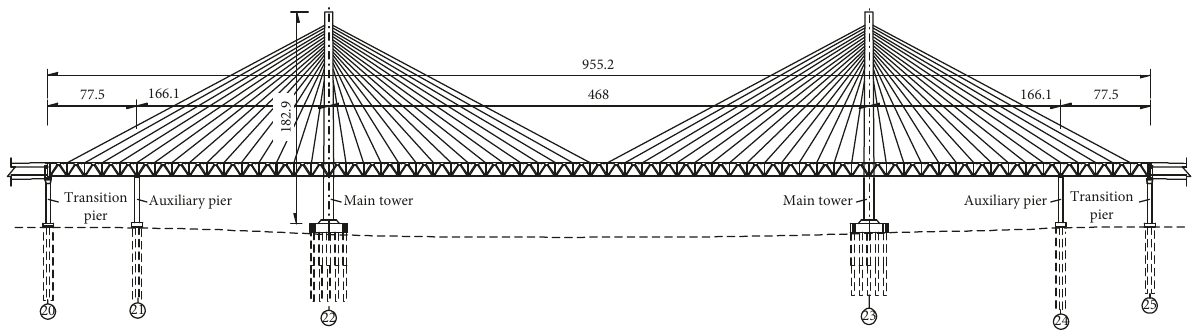
Figure 1: Elevation layout of Niutianyang Bridge (unit: m).